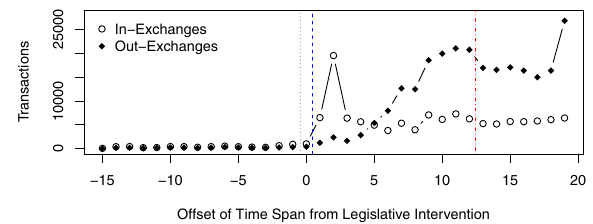
Fig. 8 Community count by louvain method. Temporal representation of the community count by Louvain method for 30-day spans. After the tax- incentives (span 0), there are 852 monthly communities on average. Although most actors are involved in a small number of communities centered on large agents, the vast majority of these communities are pairs or small clusters of users. The large community count re fl ects the large number of agents with only one or two MM partners.